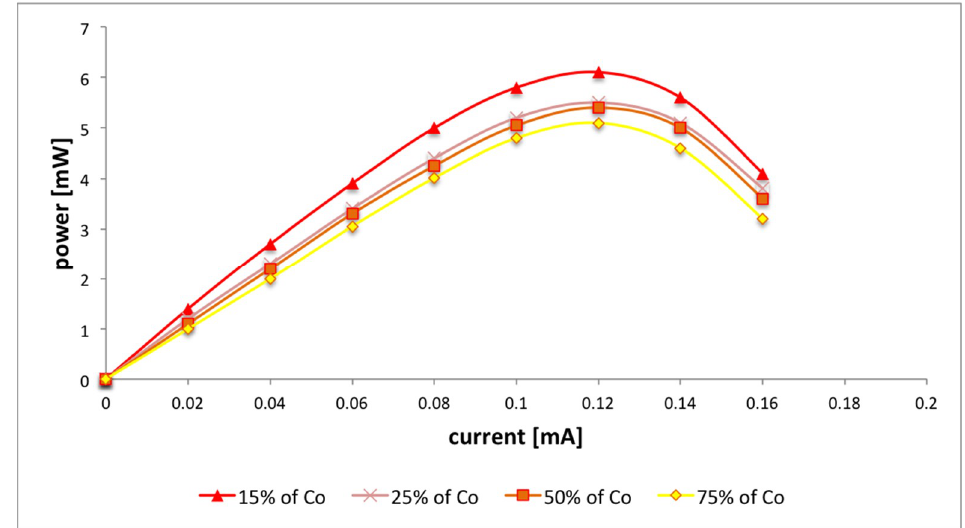
Figure 5. Power curves of microbial fuel cell (MFC) fed by wastewater from a wastewater treatment plant in a yeast factory. The content of Co in the catalyst was equal to 15, 25, 50, and 75%.